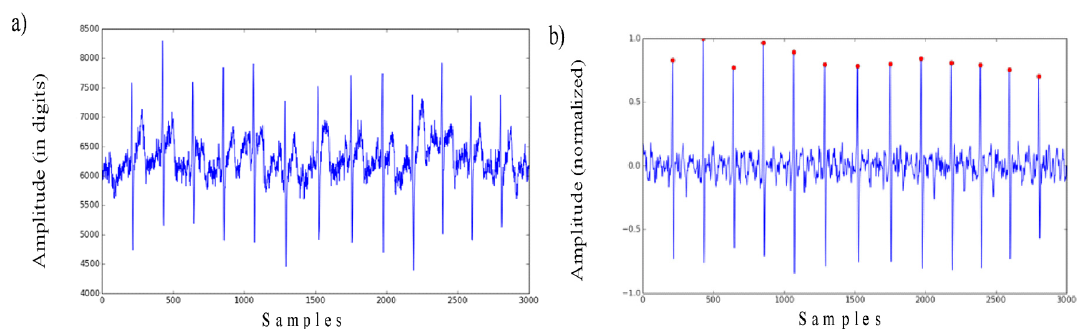
Figure 2. ( a ) Raw ECG signal and ( b ) ECG signal after filtering and normalization with the detected R peaks.